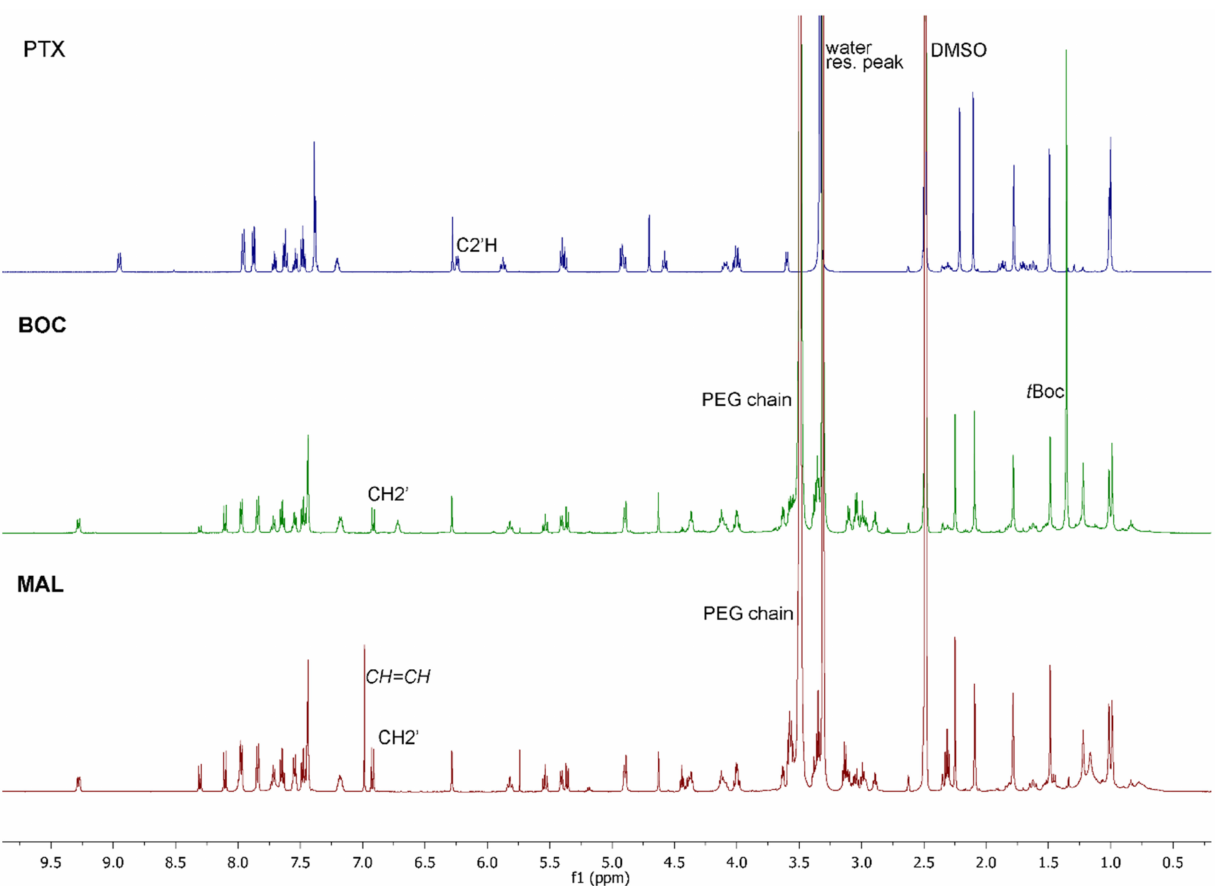
Figure 1. 1 HNMR comparison between PTX (dark blue), BOC (green), MAL (dark red). Samples were dissolved in DMSO, and spectra recorded on a 500 MHz Varian